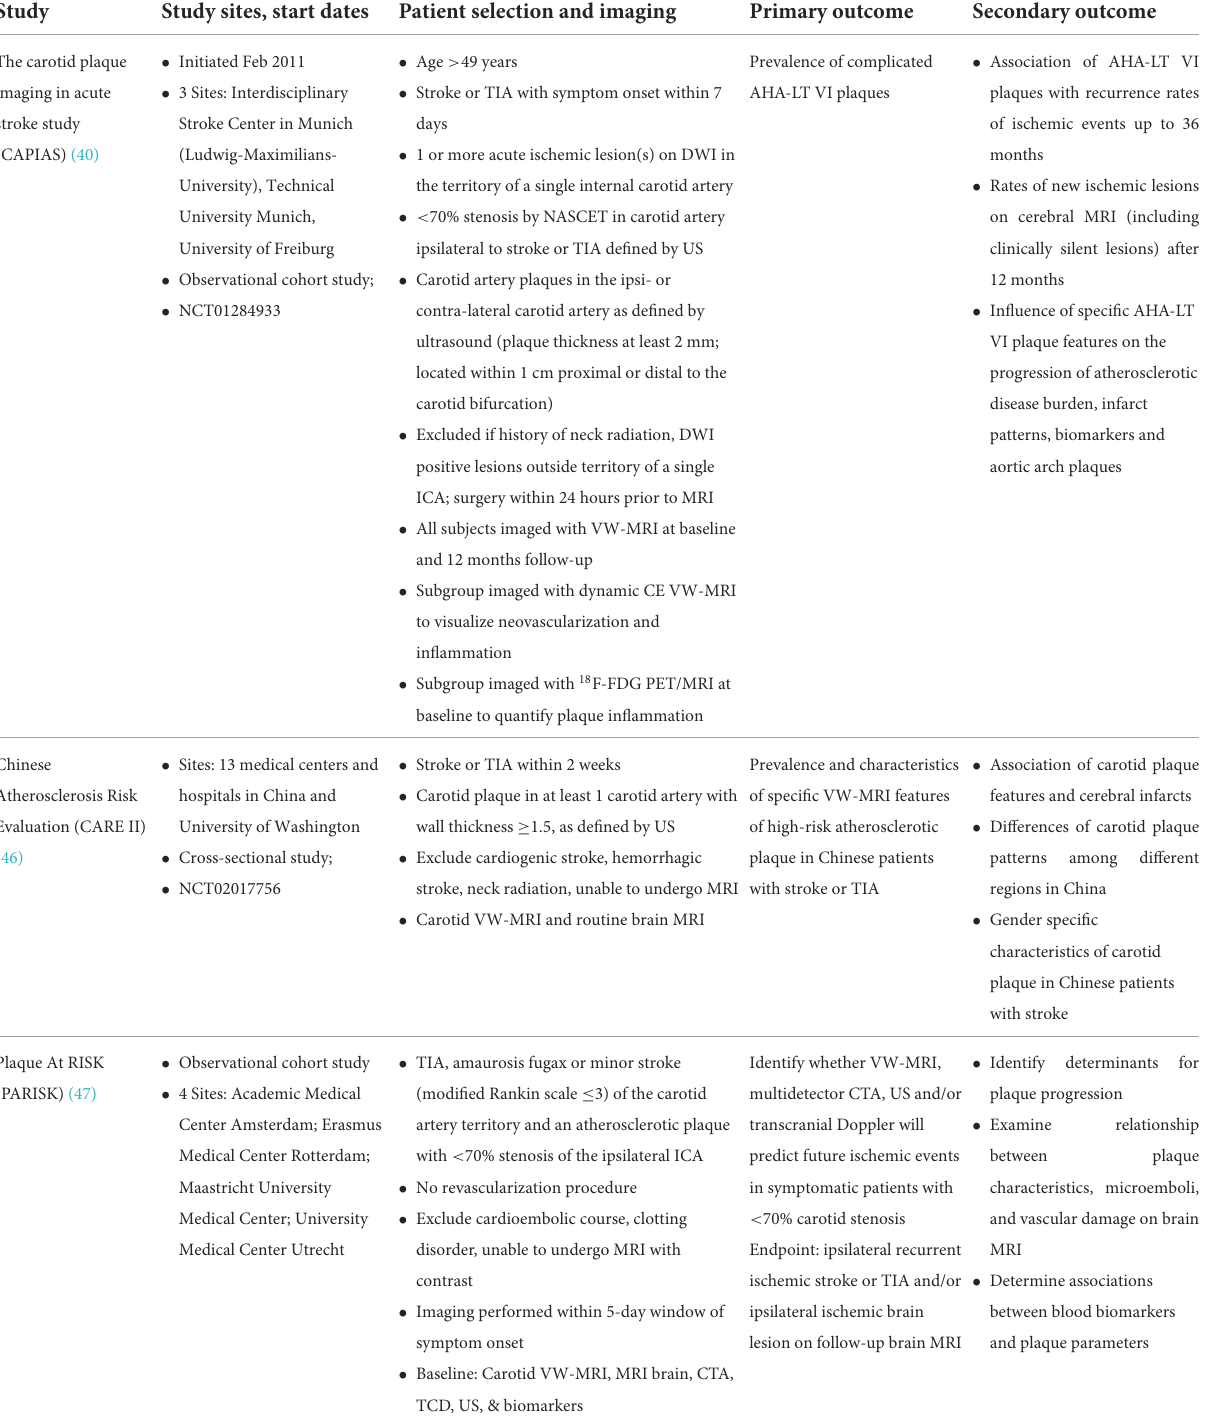
TABLE 2 Prospective carotid plaque imaging studies. Study Study sites, start